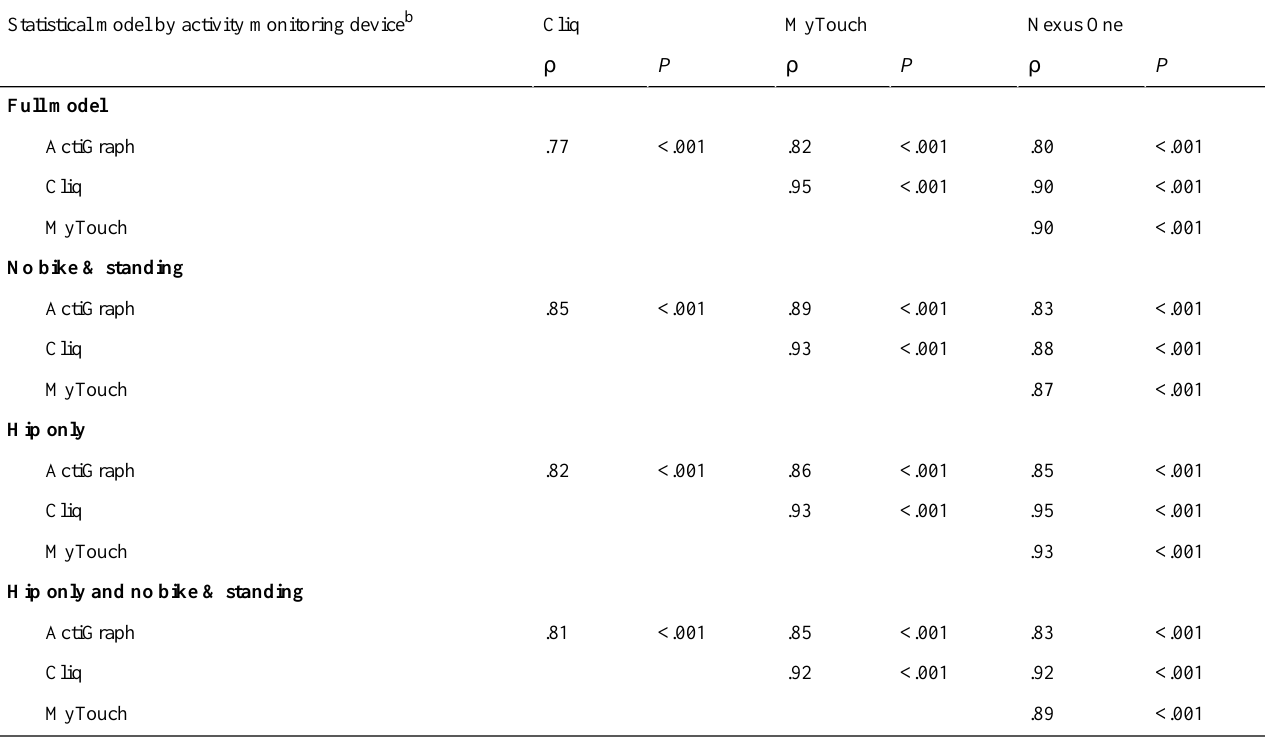
Table 1. Spearman rank order correlations a ( ρ ) between raw ActiGraph and raw phone counts for the laboratory study (N=15).